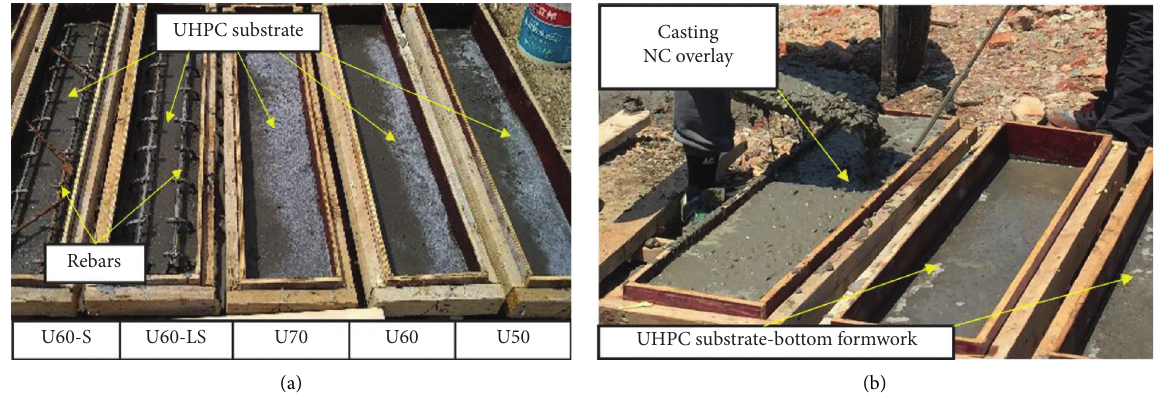
Figure 3: Construction of NC-UHPC composite decks. (a) UHPC substrate. (b) NC